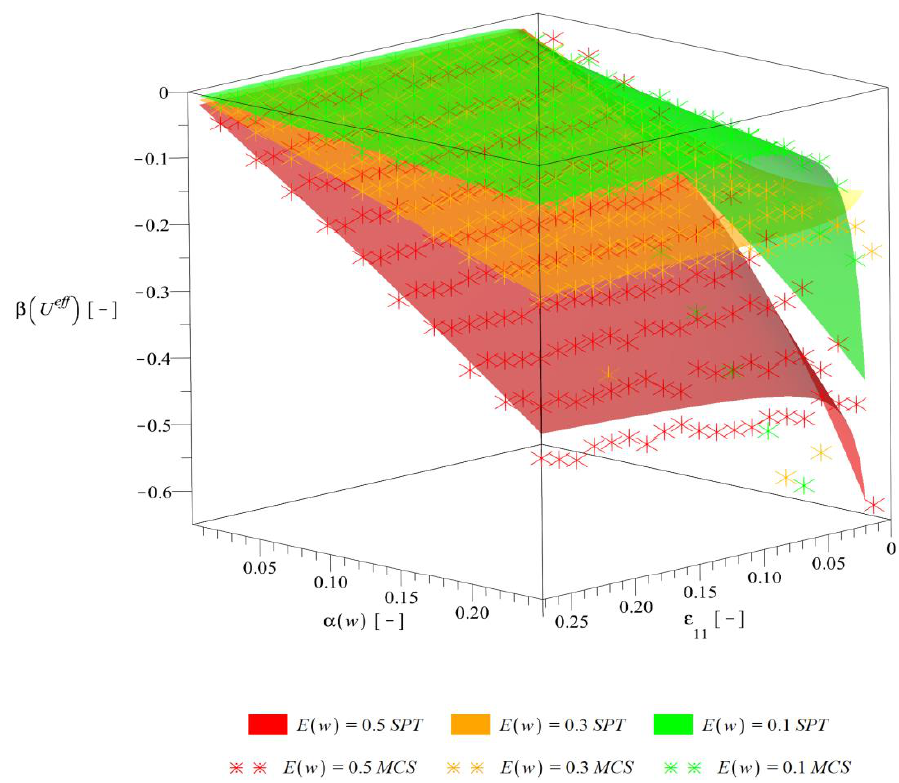
(cid:16) (cid:17) U ef f